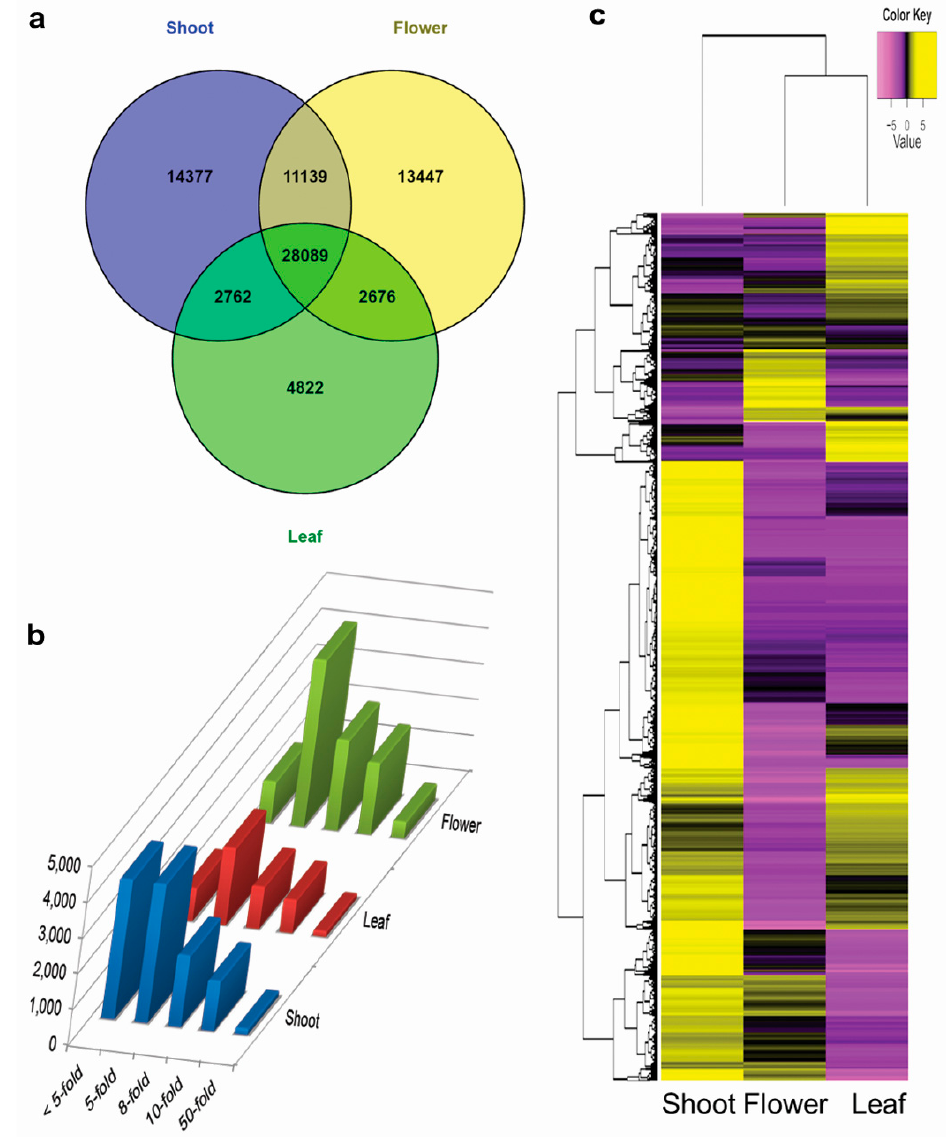
Figure 4. Tissue specific expression of C. tetragonoloba . ( a ) Expressed genes (FPKM ≥ 1) in 3 sample tissues; ( b ) expression of genes at different folds, with at each fold level of 5 or higher FPKM value, genes were found expressed higher in flower tissue sample (reproductive stage) as compared to tissue of vegetative stage (shoot and leaf); ( c ) differentially expressed genes (DEGs) vs. samples Heatmap showing cluster analysis of 38,423 differentially expressed genes for tissue-specific expression in all the 3 tissues. DEGs partitioned into 10 gene clusters with similar expression patterns with genes in each cluster ranging from 3755 to 3940. Color scale representing normalized expression values (left-top).